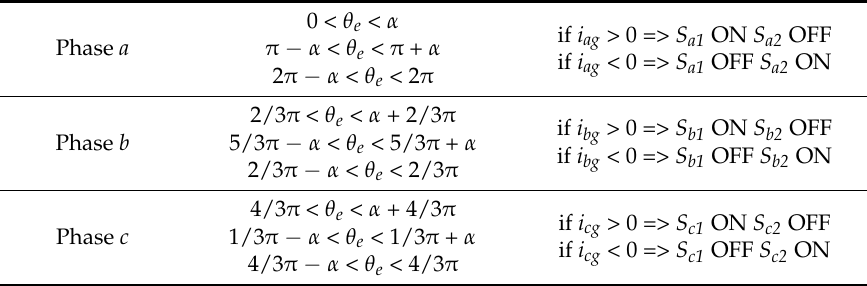
Table 1. Vienna rectifier switching table.